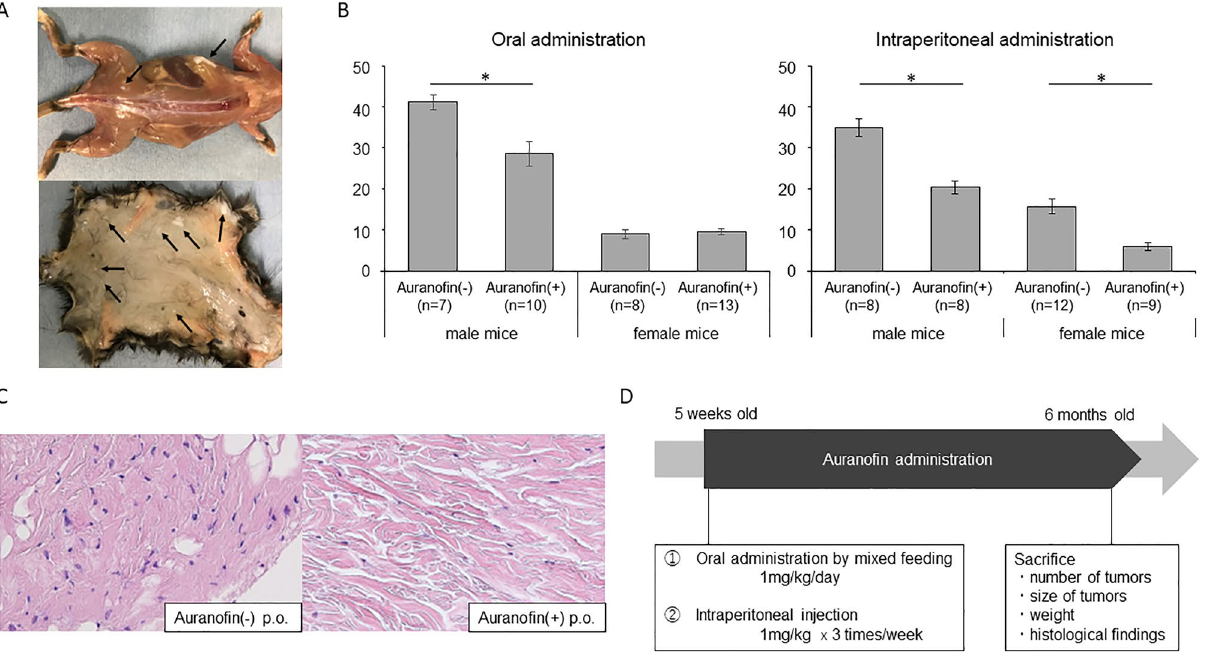
Figure 5. Schedule of auranofin administration for Apc1638N mice and effects of auranofin in in vivo DF development model mice. ( A ) Representative findings of tumor development in a Apc1638N mouse (6 months of age) (black arrows: tumorous tissues). Small white tumorous tissues of a few millimeters in size occurred subcutaneously and on the fascia. ( B ) The number of tumors that developed in Apc1638N (6 months of age) with or without treatment of auranofin by oral or intraperitoneal administration. Oral dose for mice was set at 1.0 mg/kg/day and the intraperitoneal dose was set as 1 mg/kg three times a week. The average number of tumors developed with oral administration of auranofin (10 male mice and 13 female mice) and control (7 male mice and 8 female mice), ant that with intraperitoneal administration of auranofin (8 male mice and 9 female mice) and control (8 male mice and 12 female mice) were plotted. * P < 0.01. ( C ) Pathological findings of the tumors developed in mice with or without treatment of auranofin by oral administration (6 months of age) (H&E, × 200). p.o.: per OS. ( D ) Experimental procedure in vivo. Auranofin was administered from 5 weeks to 6 months of age. Two separate experiments were performed based on the administration route, oral and intraperitoneal. Mice were sacrificed at 6 months of age, and the number of tumors, tumor size, tumor weight were calculated. Tumorous tissues were also subjected to histological